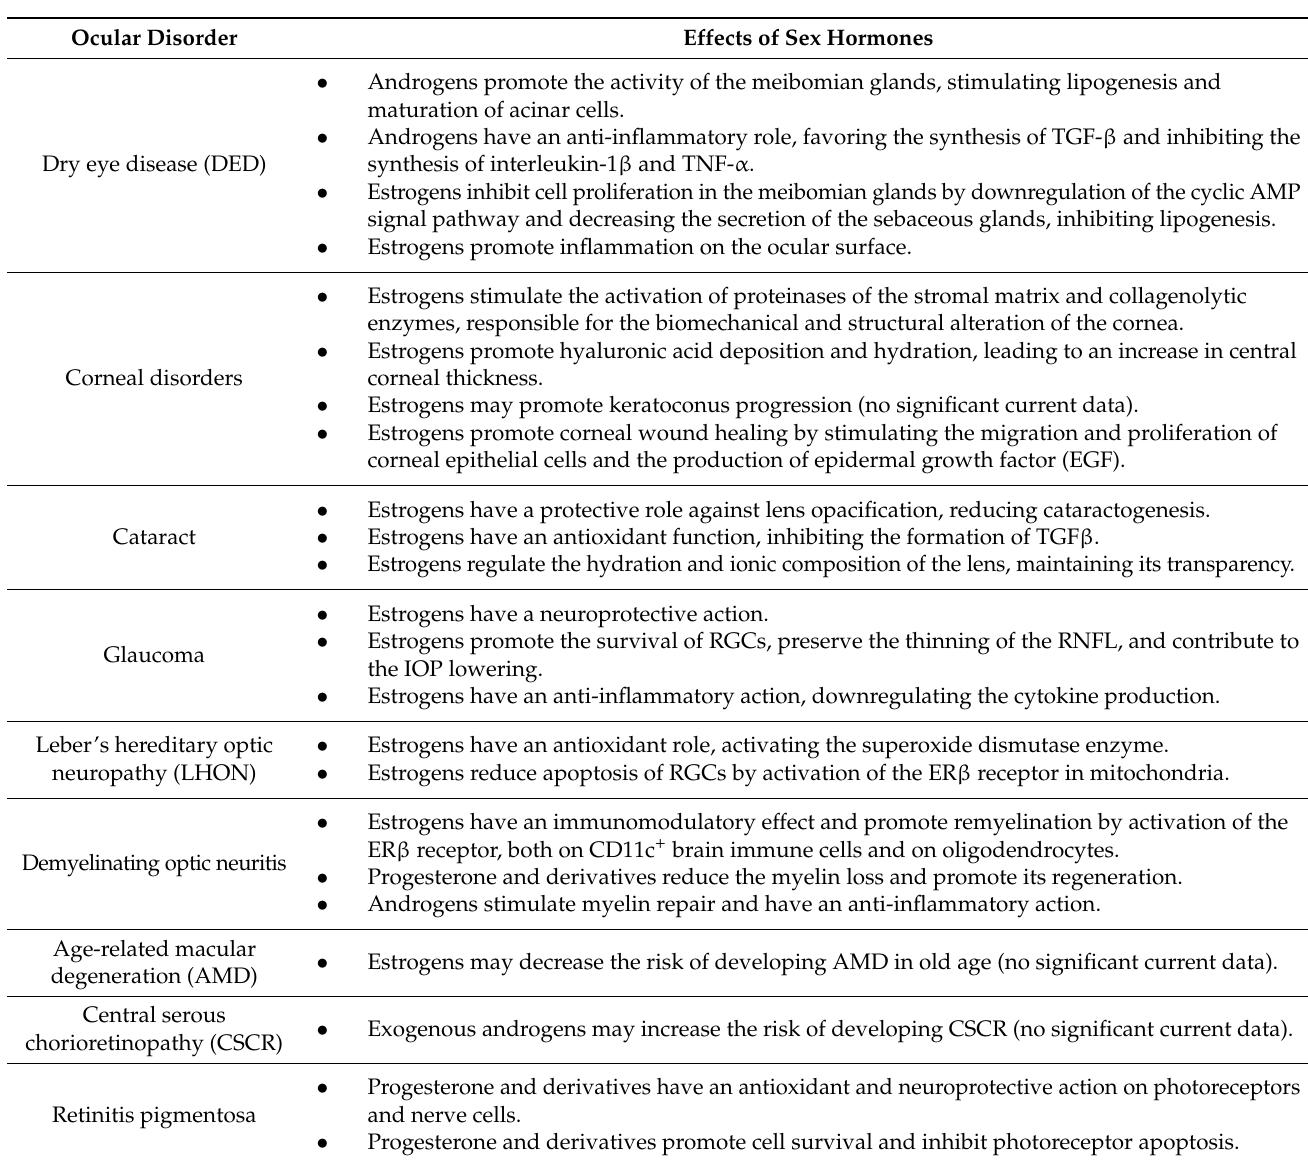
Table 2. Effects of sex hormones on ocular